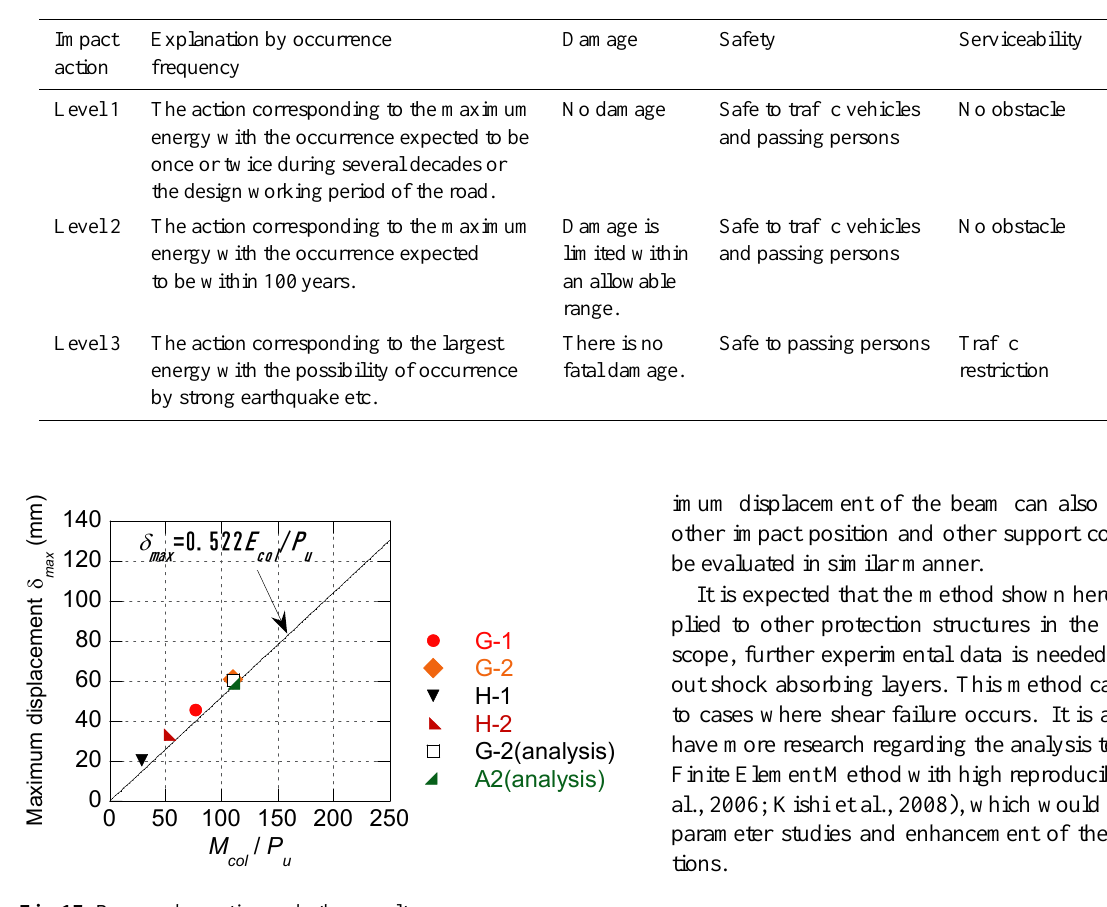
Table 5. The levels of impact action and the performance criterions of a protection structure or a structural member.